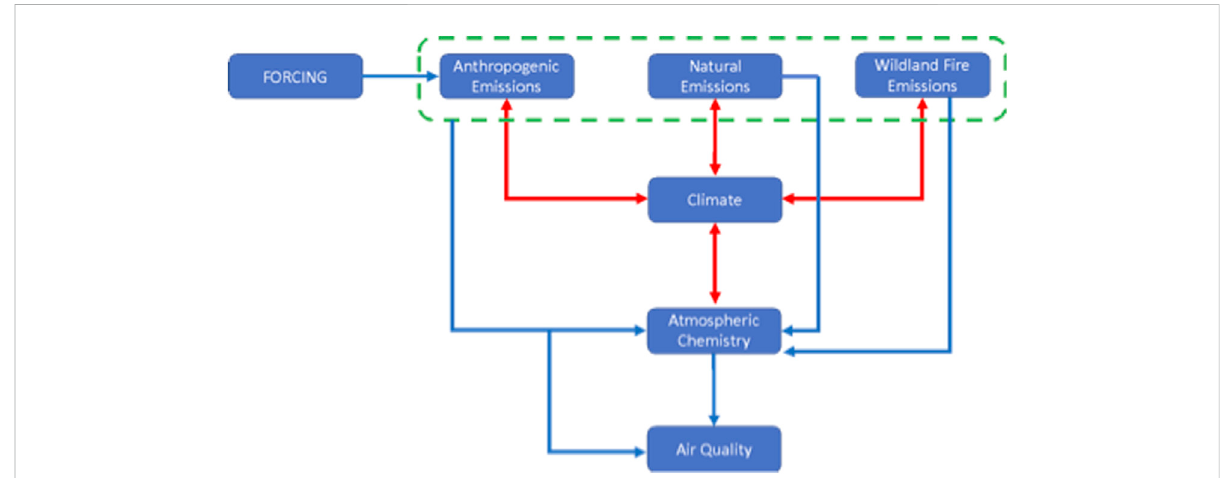
FIGURE 1 Interactions between climate, emissions and air quality (adopted from Jacob and Winner, 2009). Forcing term refers to the changes in the socioeconomic factors. The green dashed box shows the different emissions, while the red and the blue arrows show two-way and one-way interactions,